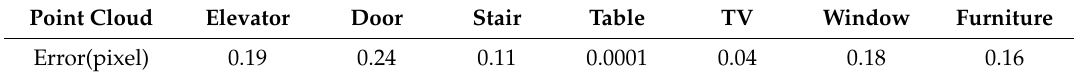
Table 3. The registration error.